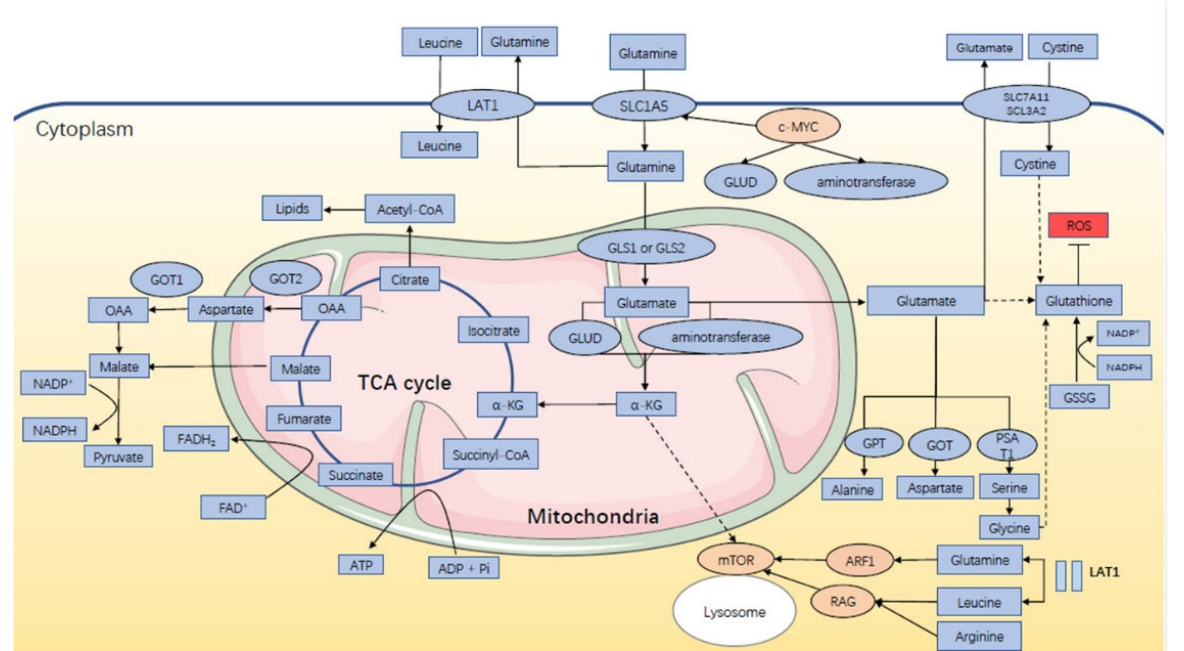
Figure 1. Glutamine metabolism in endocrine ‐ related cancers.